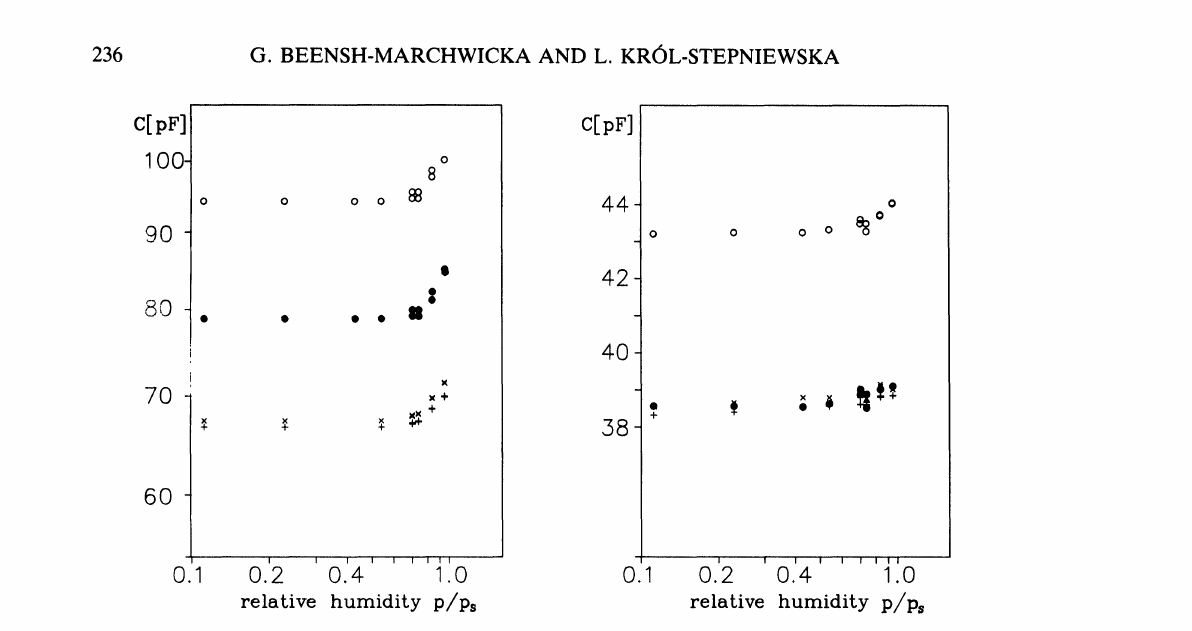
FIGURE 2 Capacitance characteristics of an A1203 capacitors versus relative humidity for barrier- type layer a) and porous-barrier layer b). Electrode materials as a parameter: (O) bump electrodes and ((3) NiCr-Au-Cr film electrodes or () bump electrodes and (+) NiCr film electrodes of the complementary pairs of tested devices.